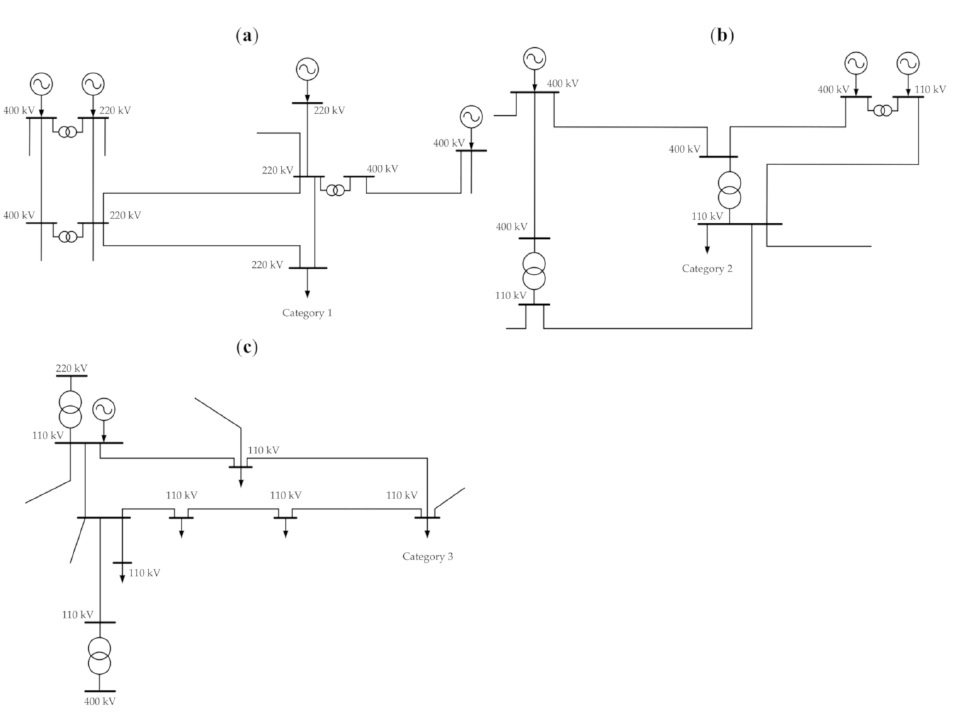
Figure 9. Example supply method of the industrial customers belonging to the different